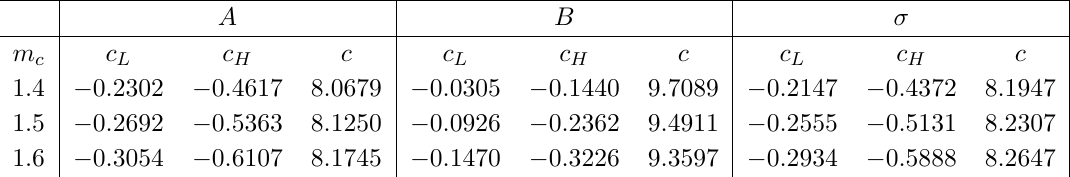
Table 2 . The coefficients c L , c H , and c for e + e − → J/ψ + χ c 0 at is GeV.